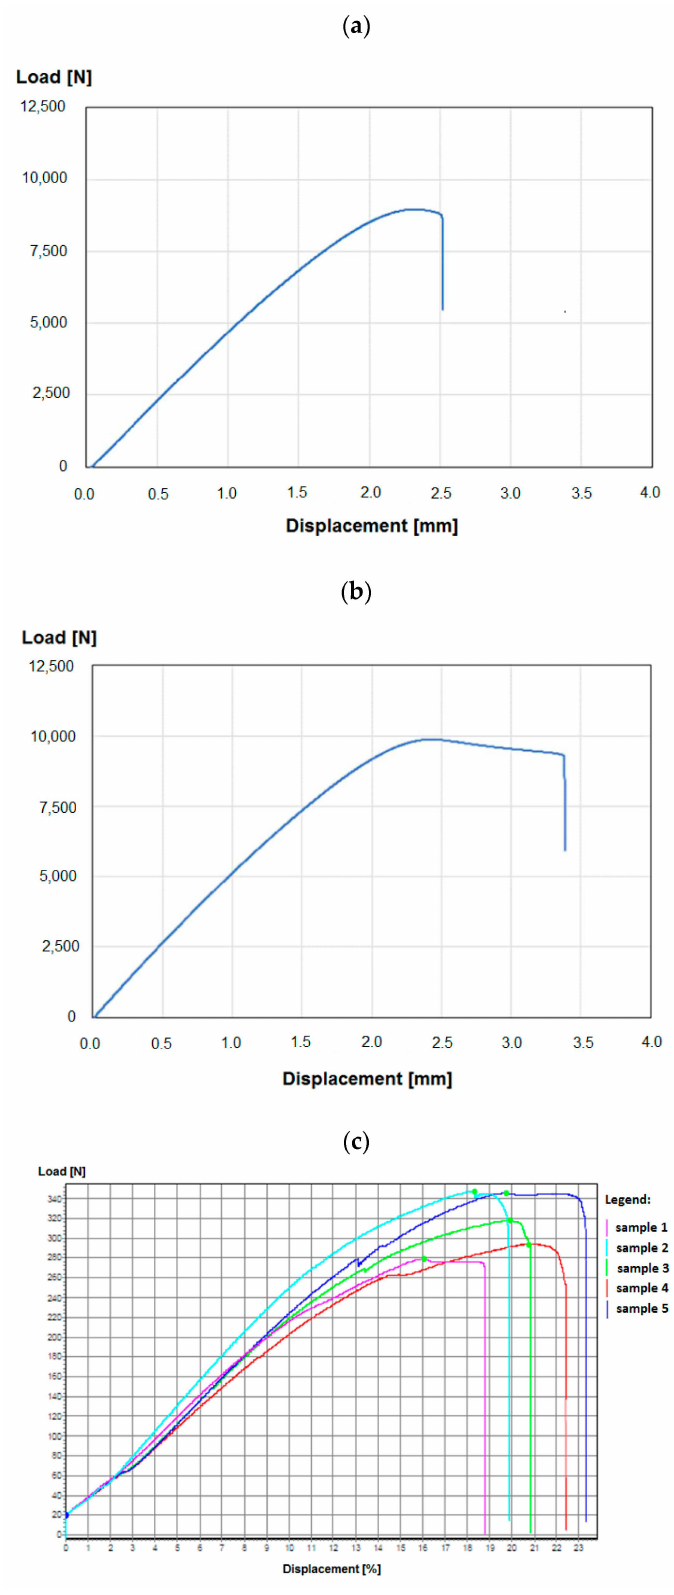
Figure 7. Selected tensile strength test results: ( a ) lever, ( b ) cap, ( c ) tensile strength of the cap— comparison of results for individual